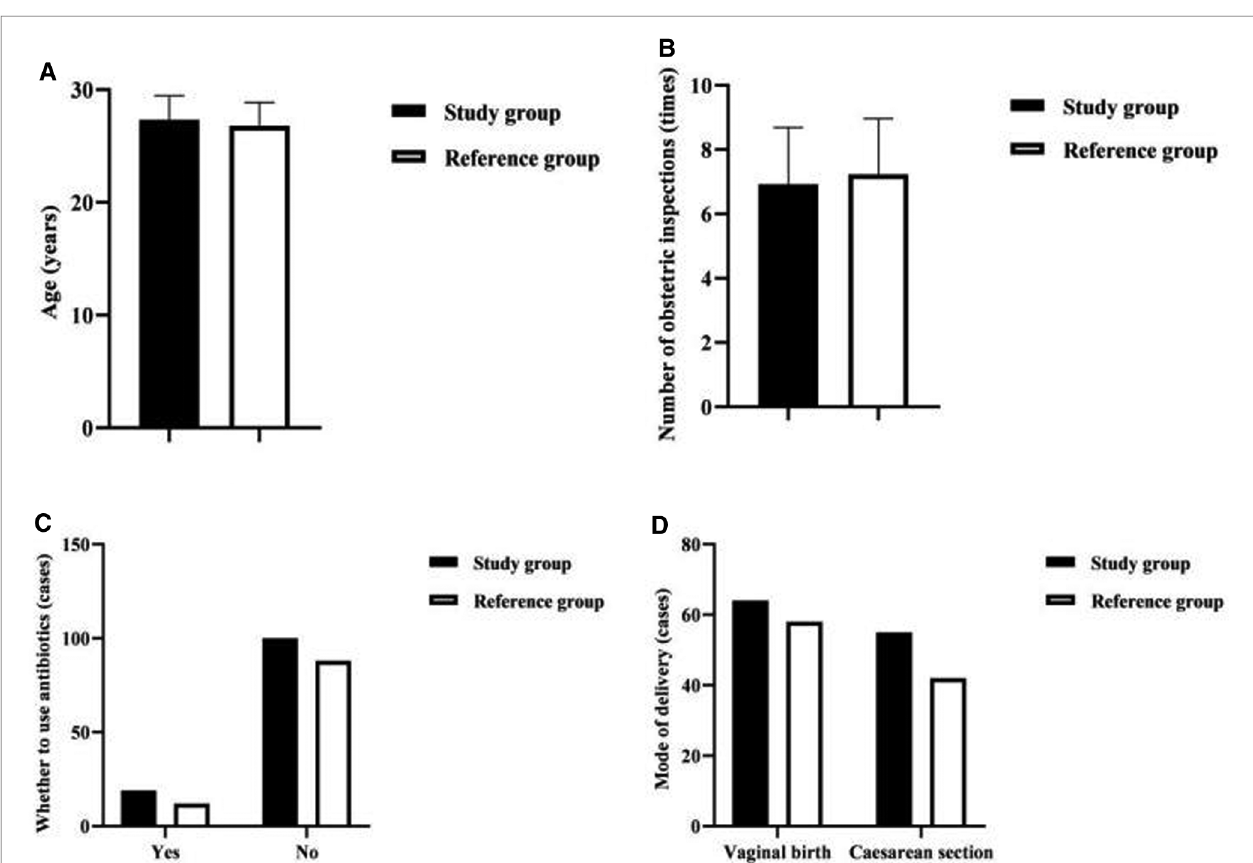
FIGURE 2 | Analysis of the maternal factors of EONBI. Note: ( A ) Comparison of maternal age in both groups (years). ( B ) Comparison of the number of obstetric inspections in both groups (times). ( C ) Comparison of whether to use antibiotics in both groups (cases). ( D ) Comparison of the mode of delivery in both groups (cases).